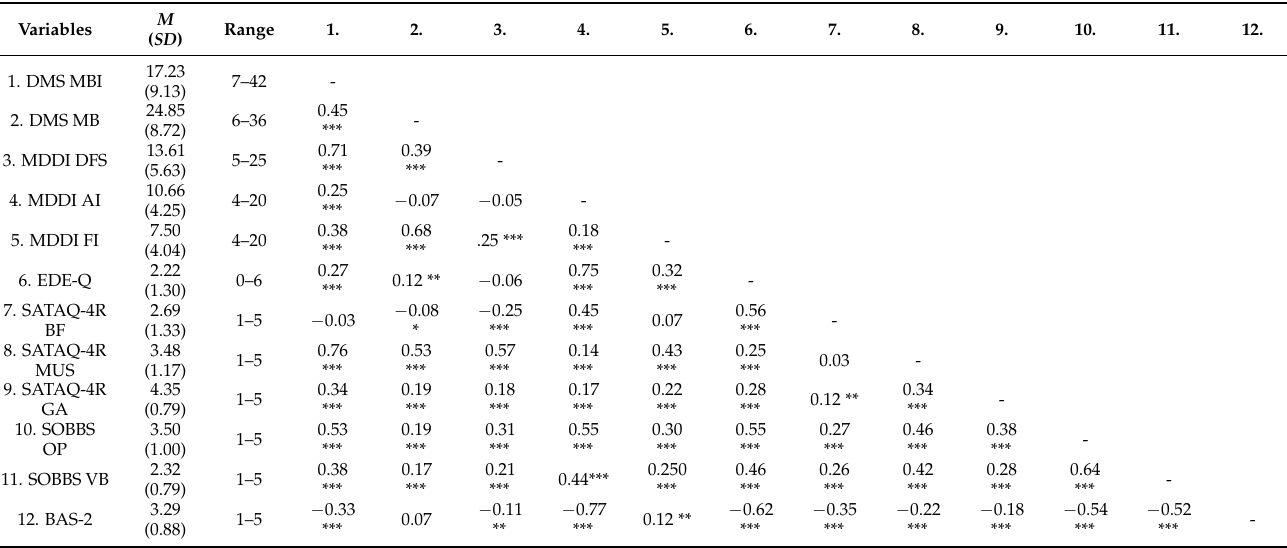
Table 4. Descriptive statistics and bivariate correlations between the MDDI and DMS, and convergent